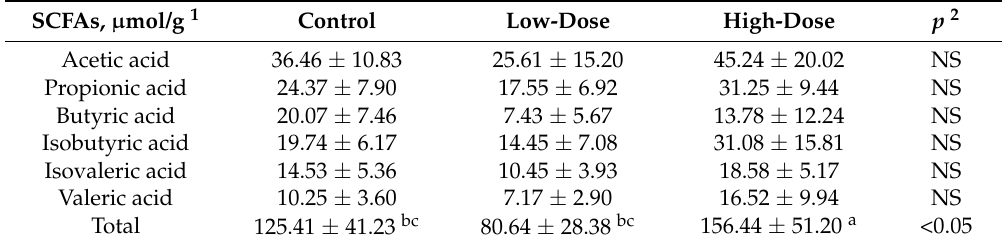
Table 2. Concentration of short-chain fatty acids (SCFAs) in feces of mice in different groups. SCFAs, µ mol/g 1 Control Low-Dose High-Dose p 2 Acetic acid 36.46 ± 10.83 25.61 ± 15.20 45.24 ± 20.02 NS Propionic acid 24.37 ± 7.90 17.55 ± 6.92 31.25 ± 9.44 NS Butyric acid 20.07 ± 7.46 Isobutyric